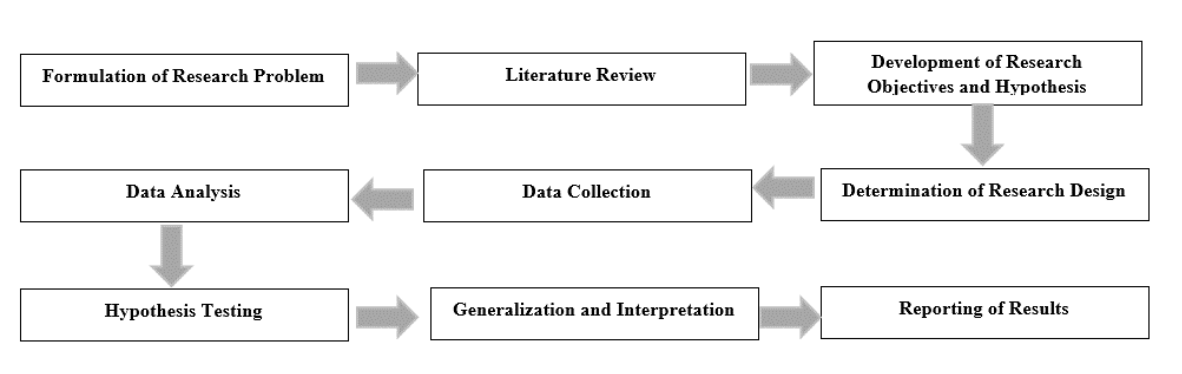
Figure 3. Research Methodology Flow